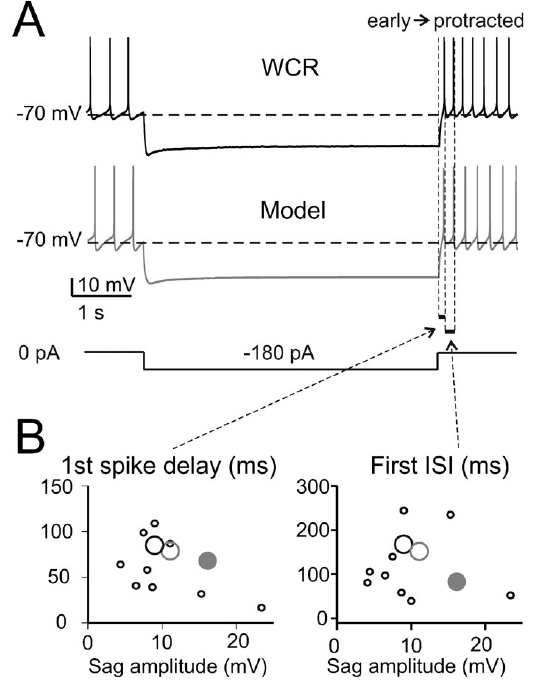
Figure 3. The response to hyperpolarization and rebound excitation . ( A ) The WCR from a Golgi cell shows sagging inward rectification in response to hyperpolarizing current injection and, at the end of the hyperpolarization, rebound excitation with an early and a protracted phase of intensified firing. Simulations of this specific experiment (parameters were adjusted to mimic the experimental trace in detail: leakage reversal potential (cid:1) 64.5mV, I K-slow 90%, I h-HCN1 60 %, I h-HCN2 12.5 % of their value in the canonical model) show that the model could faithfully reproduce sagging inward rectification and rebound excitation (gray trace). The step-current protocol is shown at the bottom. ( B ) The plots report the time to first spike and the first ISI during rebound excitation as a function of sag amplitude in 10 Golgi cells (black circles, the larger one corresponding to the trace in A) stimulated using the protocol shown in A. Note that the canonical model (large gray dots) did not significantly differ from the data (p > 0.13, t-test). Even the model adjusted to match the specific trace shown in A (large gray circle, see details reported in A) falls within the experimental data scatter